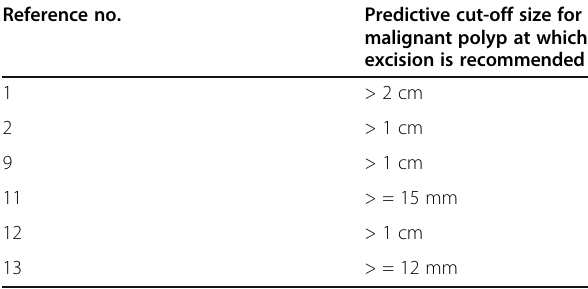
Table 4 Criteria for prophylactic removal Reference